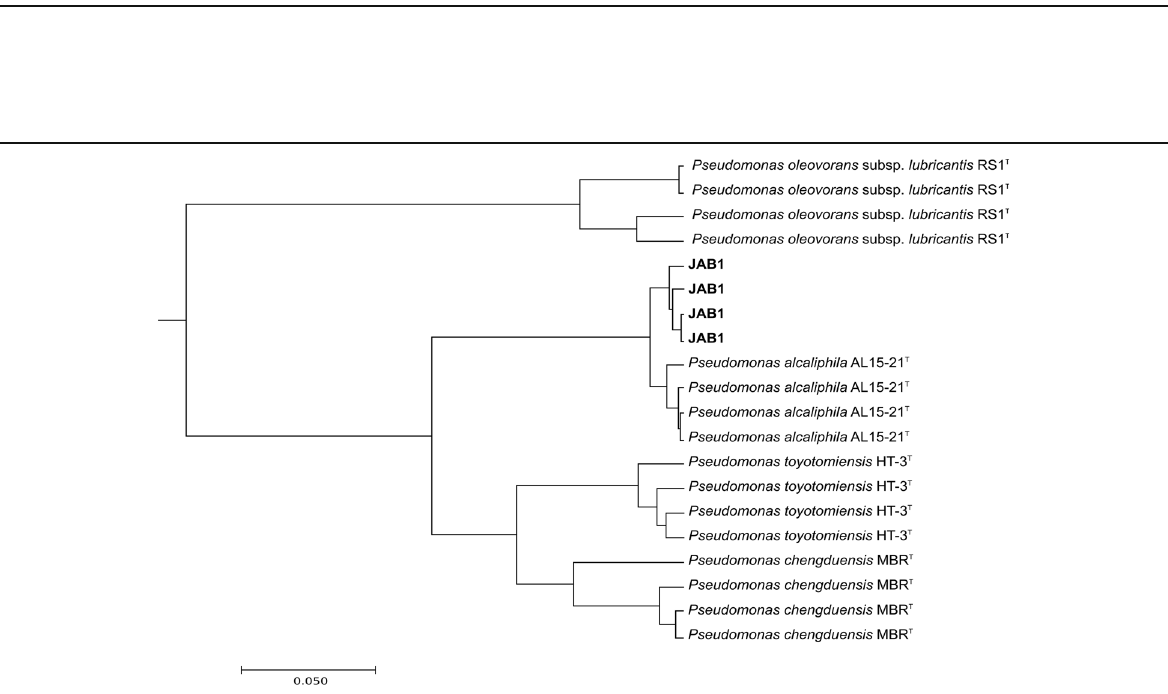
Fig. 2 Phylogenetic tree indicating current phylogenetic placement of strain JAB1.The phylogenetic tree was constructed in MEGA7 [62] using secondary structure-based alignment of 16S rRNA gene sequences of the JAB1 strain (four copies of the 16S rRNA gene retrieved from the JAB1 genome) and its closest relatives [63]. The evolutionary distances were computed using the Kimura 2-parameter method [64]. All positions with less than 95% site coverage were eliminated; there were a total of 1375 positions in the final dataset. The tree construction method used was Neighbor-Joining [65]. The bootstrap test (1000 replicates) was used to test tree topology [66]; only bootstrap values >70 are